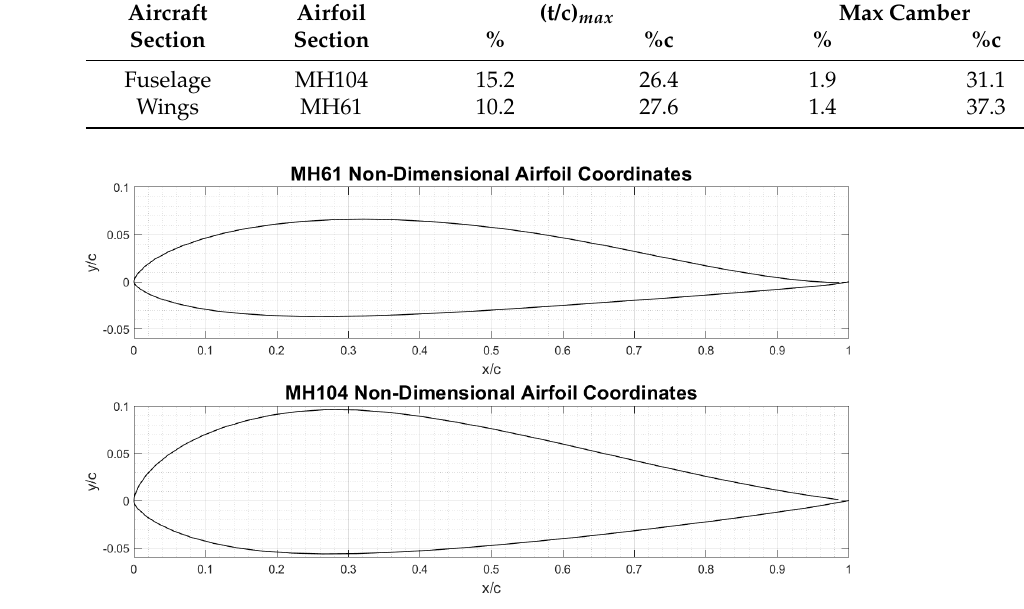
Figure 3. Profiles of the MH61 and MH104 reflex